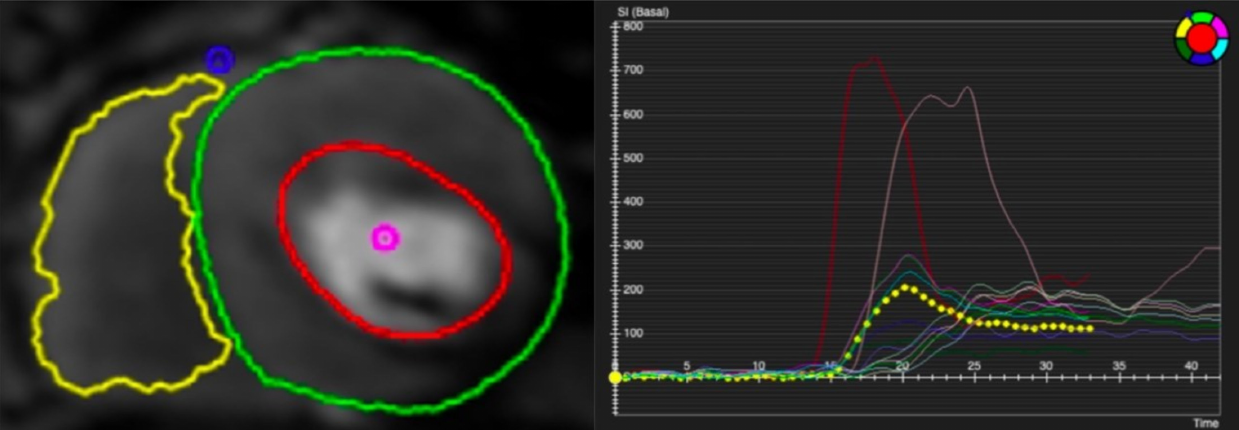
Figure 5. Contoured perfusion image ( left ) and signal intensity graph ( right ). Left panel demonstrates the contouring of right ventricle (yellow circle) and epicardium (green circle) and subendocardium (red circle) of left ventricle. Right panel shows the signal profile of each segment and blood